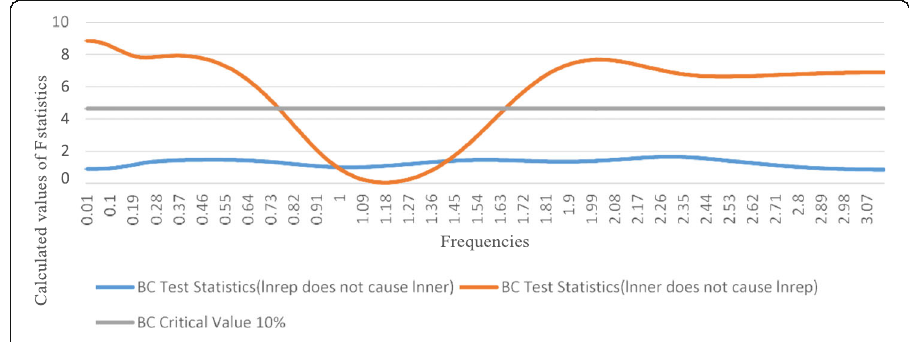
Fig. 5 The frequency domain causality between nominal exchange rate and oil